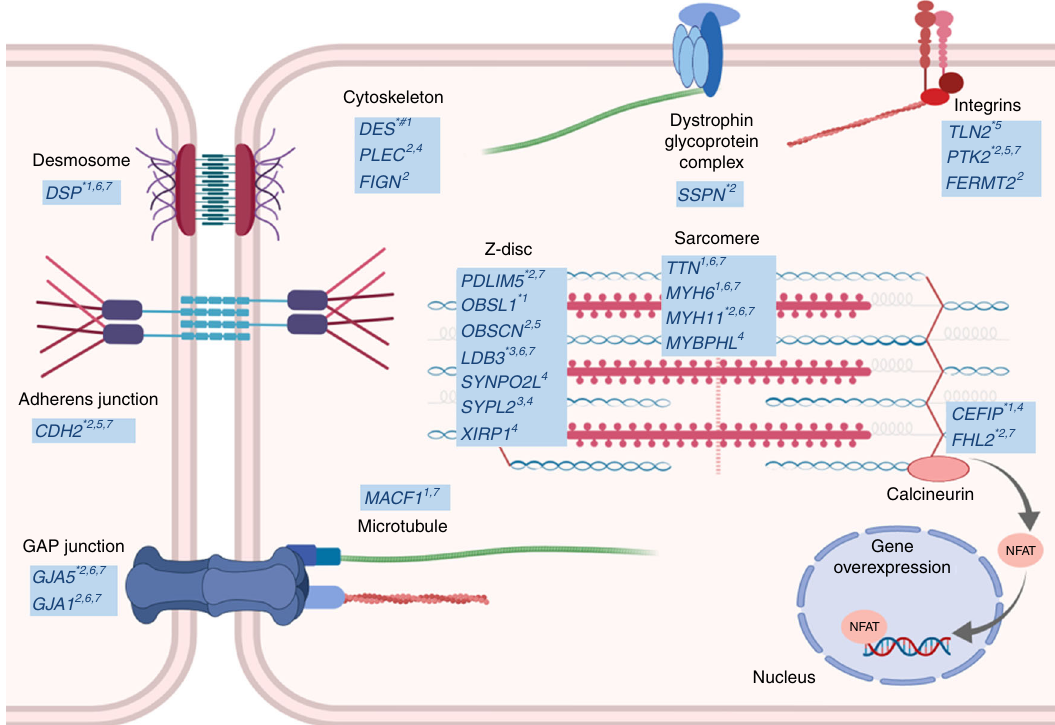
Fig. 5 Candidate genes in PR interval loci encoding proteins involved in cardiac muscle cytoskeleton. Candidate genes or encoded proteins are indicated by a star symbol in the fi gure and are listed in Supplementary Data 3. More information about the genes is provided in Supplementary Data 18 and 19. This fi gure was created with BioRender. *Previously not reported locus, # genome-wide signi fi cant locus in transformed trait meta-analysis. 1 Missense variant; 2 Nearest gene to the lead variant; 3 Gene within the region ( r 2 > 0.5); 4 Variant(s) in the locus are associated with gene expression in left ventricle and/or right atrial appendage; 5 Left ventricle best HiC locus interactor (RegulomeDB score ≤ 2); 6 Animal model; 7 Monogenic disease with a cardiovascular